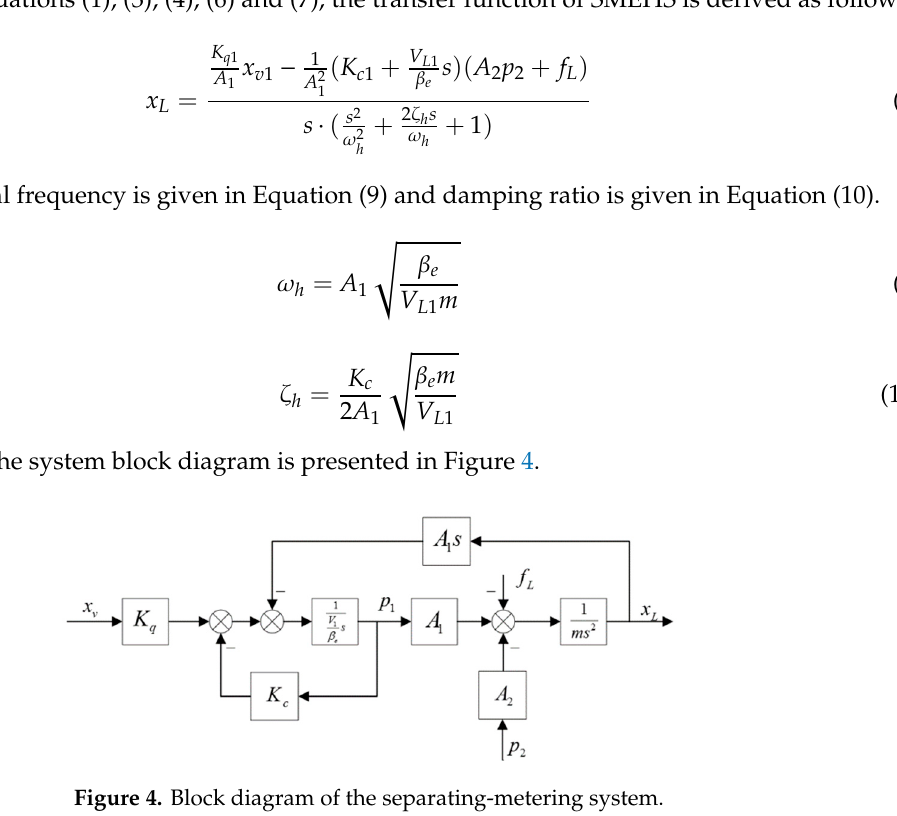
Figure 4. Block diagram of the separating-metering system.